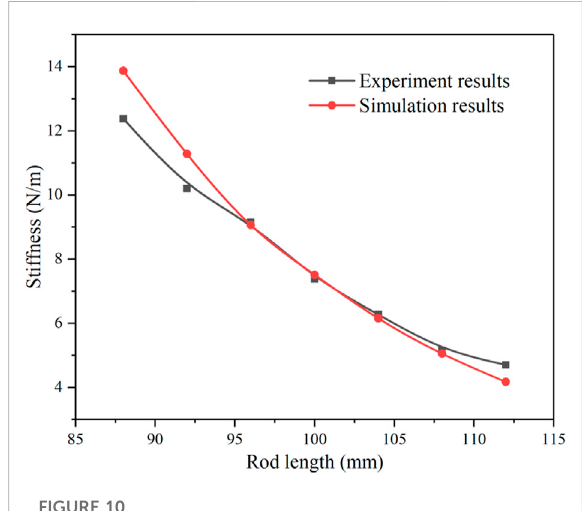
FIGURE 8 Simulated repulsive forces for different offset distances with various rod lengths.